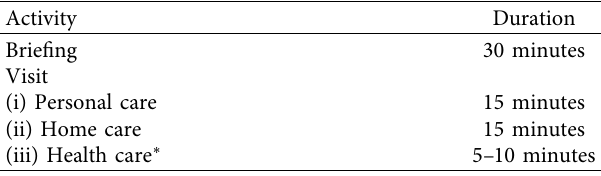
Table 2: Details of home care activities per visit.